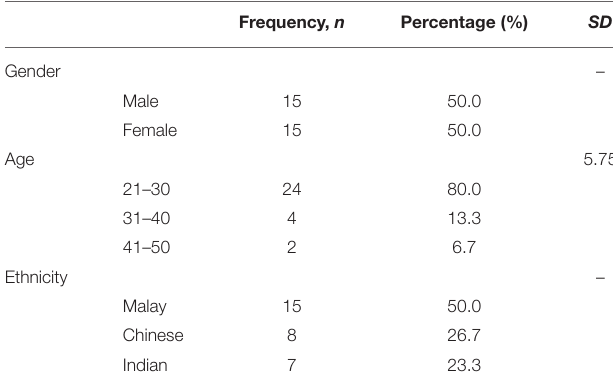
TABLE 1 | Demographics of the